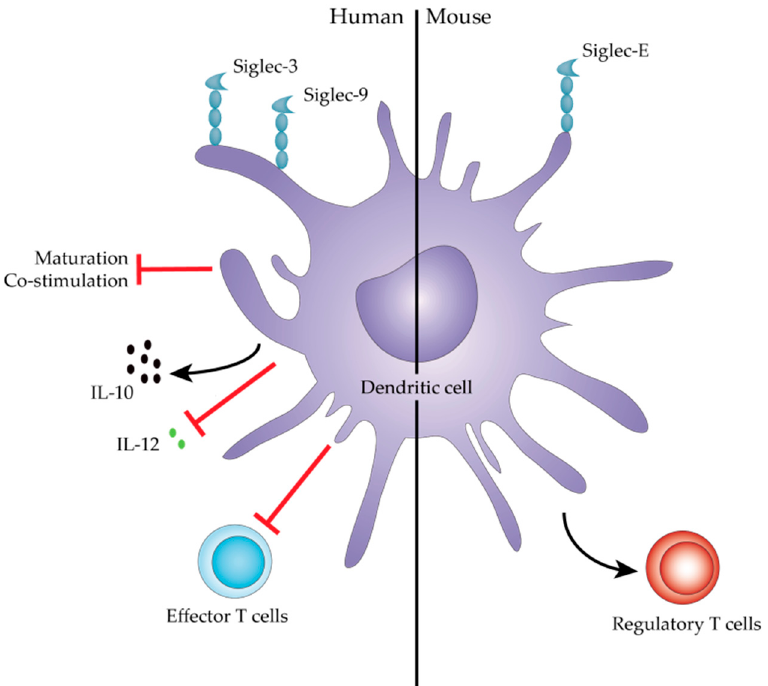
Figure 3. Immune modulation by human and mouse Siglec + dendritic cells. Depicted are the Siglec ‐ mediated effects on DC and T cell responses after Siglec engagement by tumor ‐ associated glycoproteins and sialylated O ‐ glycans, or through co ‐ culture with sialylated tumor cells. In mice, these effects are mediated by Siglec ‐ E, whereas in humans Siglec ‐ 3 and ‐ 9 are known to modulate DC immunity.